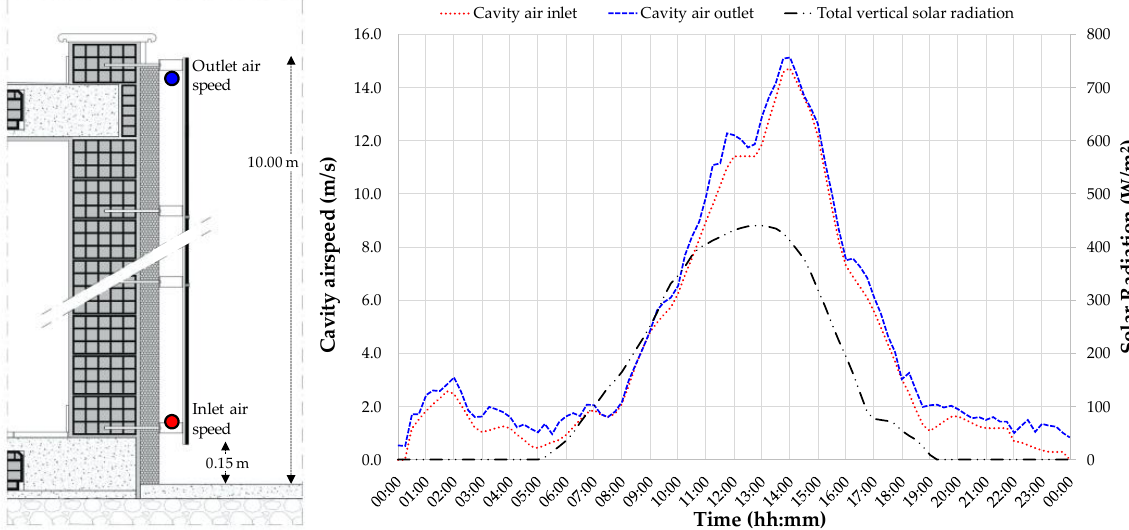
Figure 18. Simulated values of the airspeed at the inlet and the outlet of the air cavity for a typical summer day.